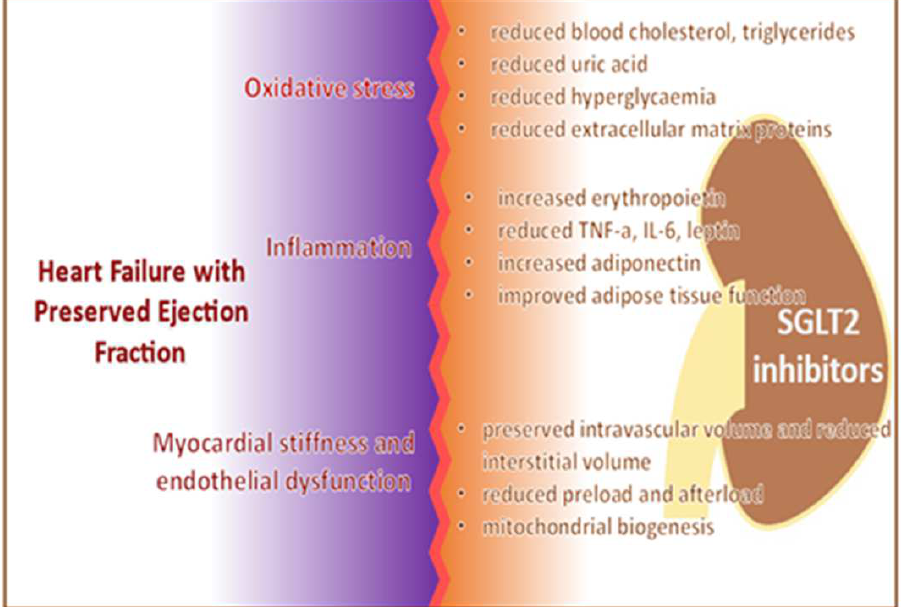
Figure 3. Mechanism of action of sodium glucose cotransporter 2 (SGLT2) inhibitors in heart failure with preserved ejection fraction.